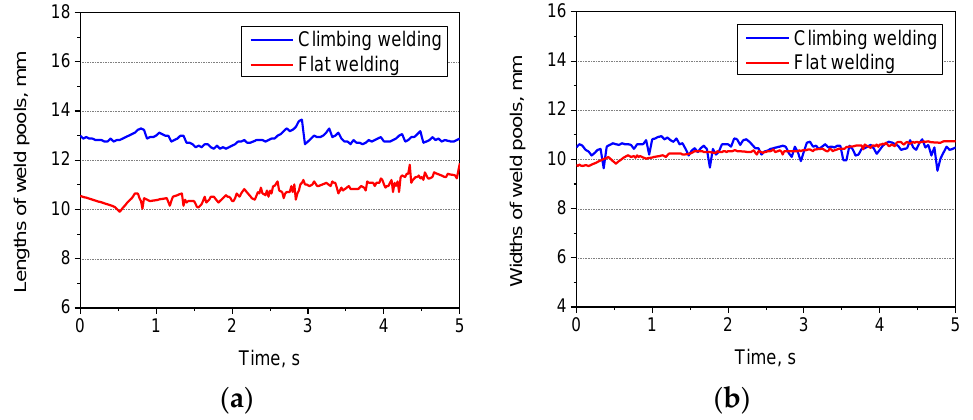
Figure 11. Variations of lengths and widths of the weld pools during climbing welding and flat welding: ( a ) lengths; and ( b ) widths.